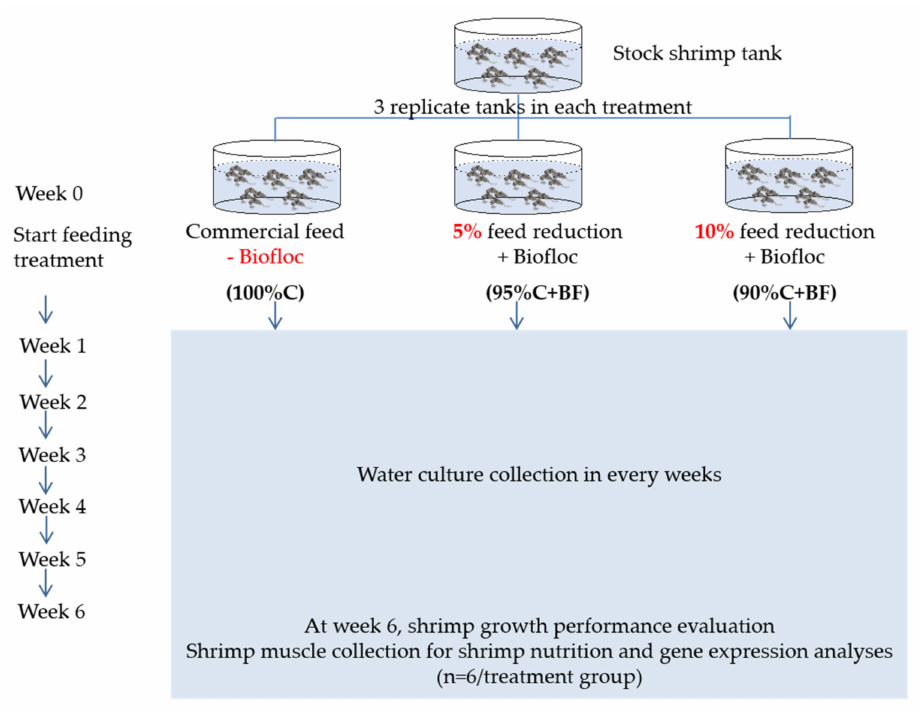
Figure 1. Experimental design in this